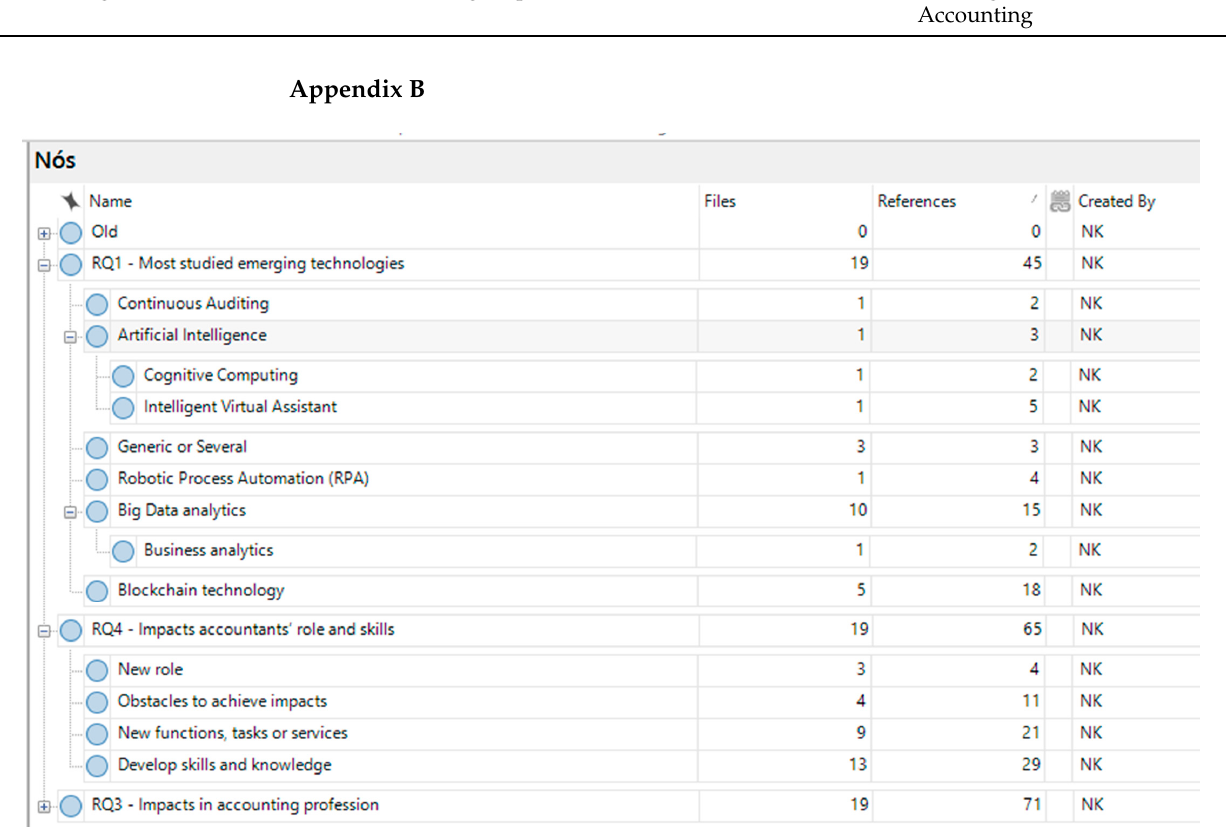
Figure A1. Content analysis categorization in NVivo.